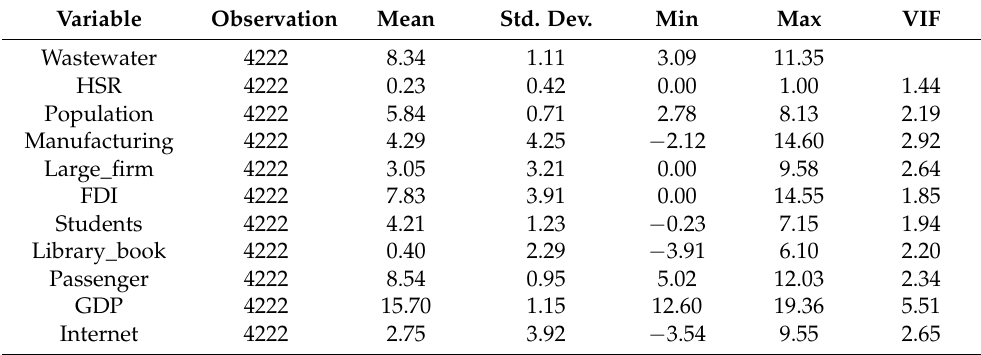
Table 1. Descriptive statistics.